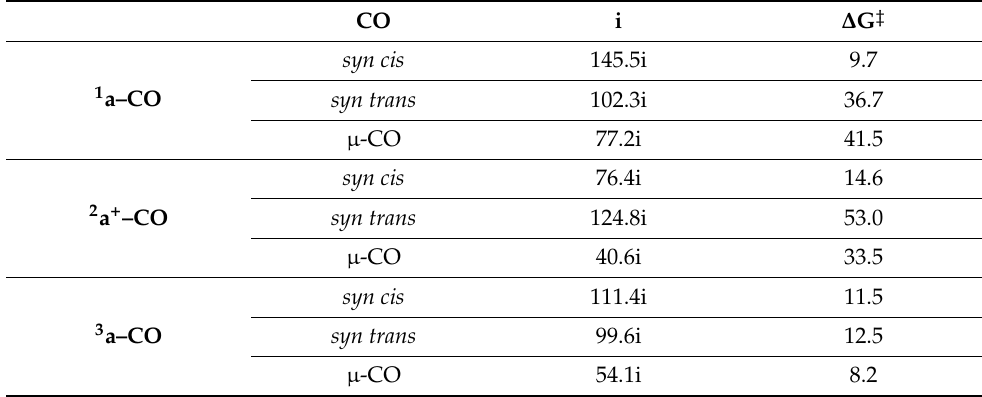
Figure 4. Total density functional theory (DFT) energy diagram and optimized main geometry parameters of 1 a–CO and cis syn , trans syn and µ -CO CO dissociation transition states and products. The energy in Hartree and free-energy barriers in kcal · mol − 1 . Distances are in Å and angles in degrees. Table 1. CO dissociation-free energy barriers ( ∆ G ‡ , in kcal · mol − 1 ). Imaginary normal mode (i) frequency (in cm − 1 ). ‡ : this is a popular symbol for free energy barriers CO I Δ G ‡